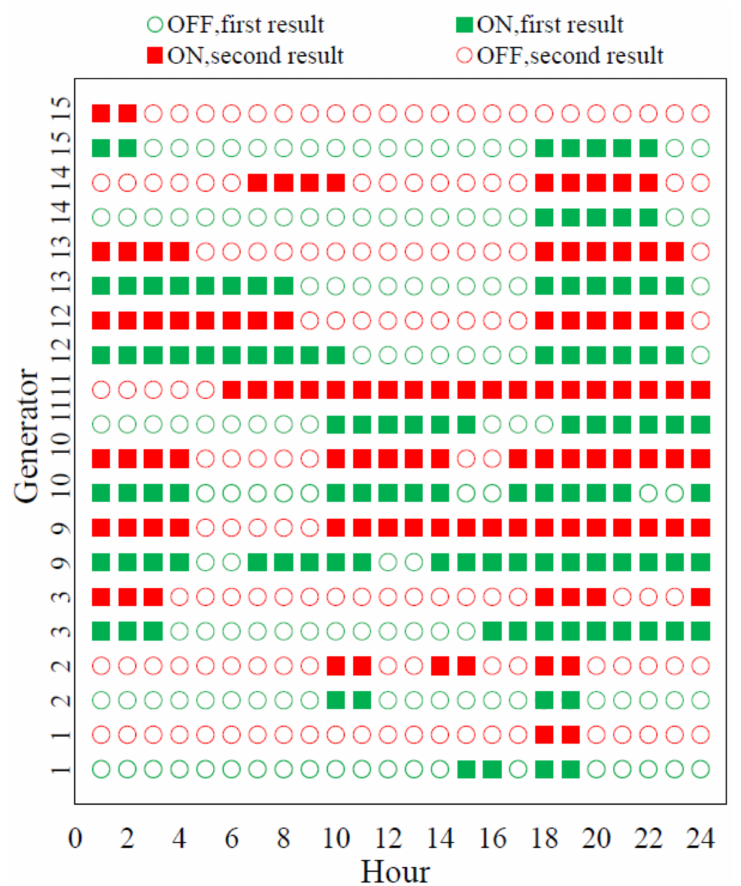
Figure 8. On and off status of